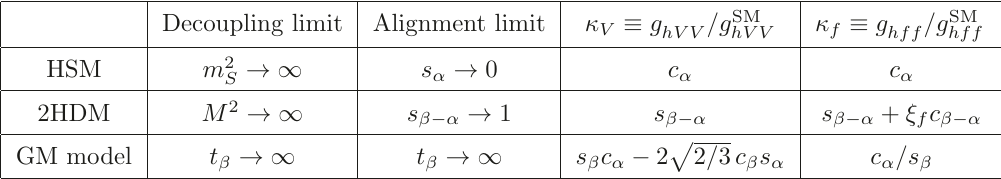
Table 2 . Summary of the relevant properties of the HSM, the 2HDM and the GM